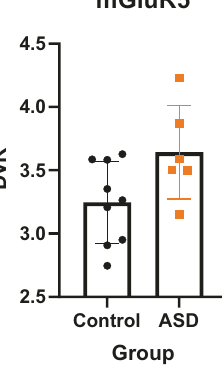
Fig. 3 Comparison of striatal/thalamic mGluR5 availability as measured by DVR (Distribution Volume Ratio) in the ASD and control groups. The control group is represented in black and the ASD (Autism Spectrum Disorder) group is represented in orange. Error bars represent one standard